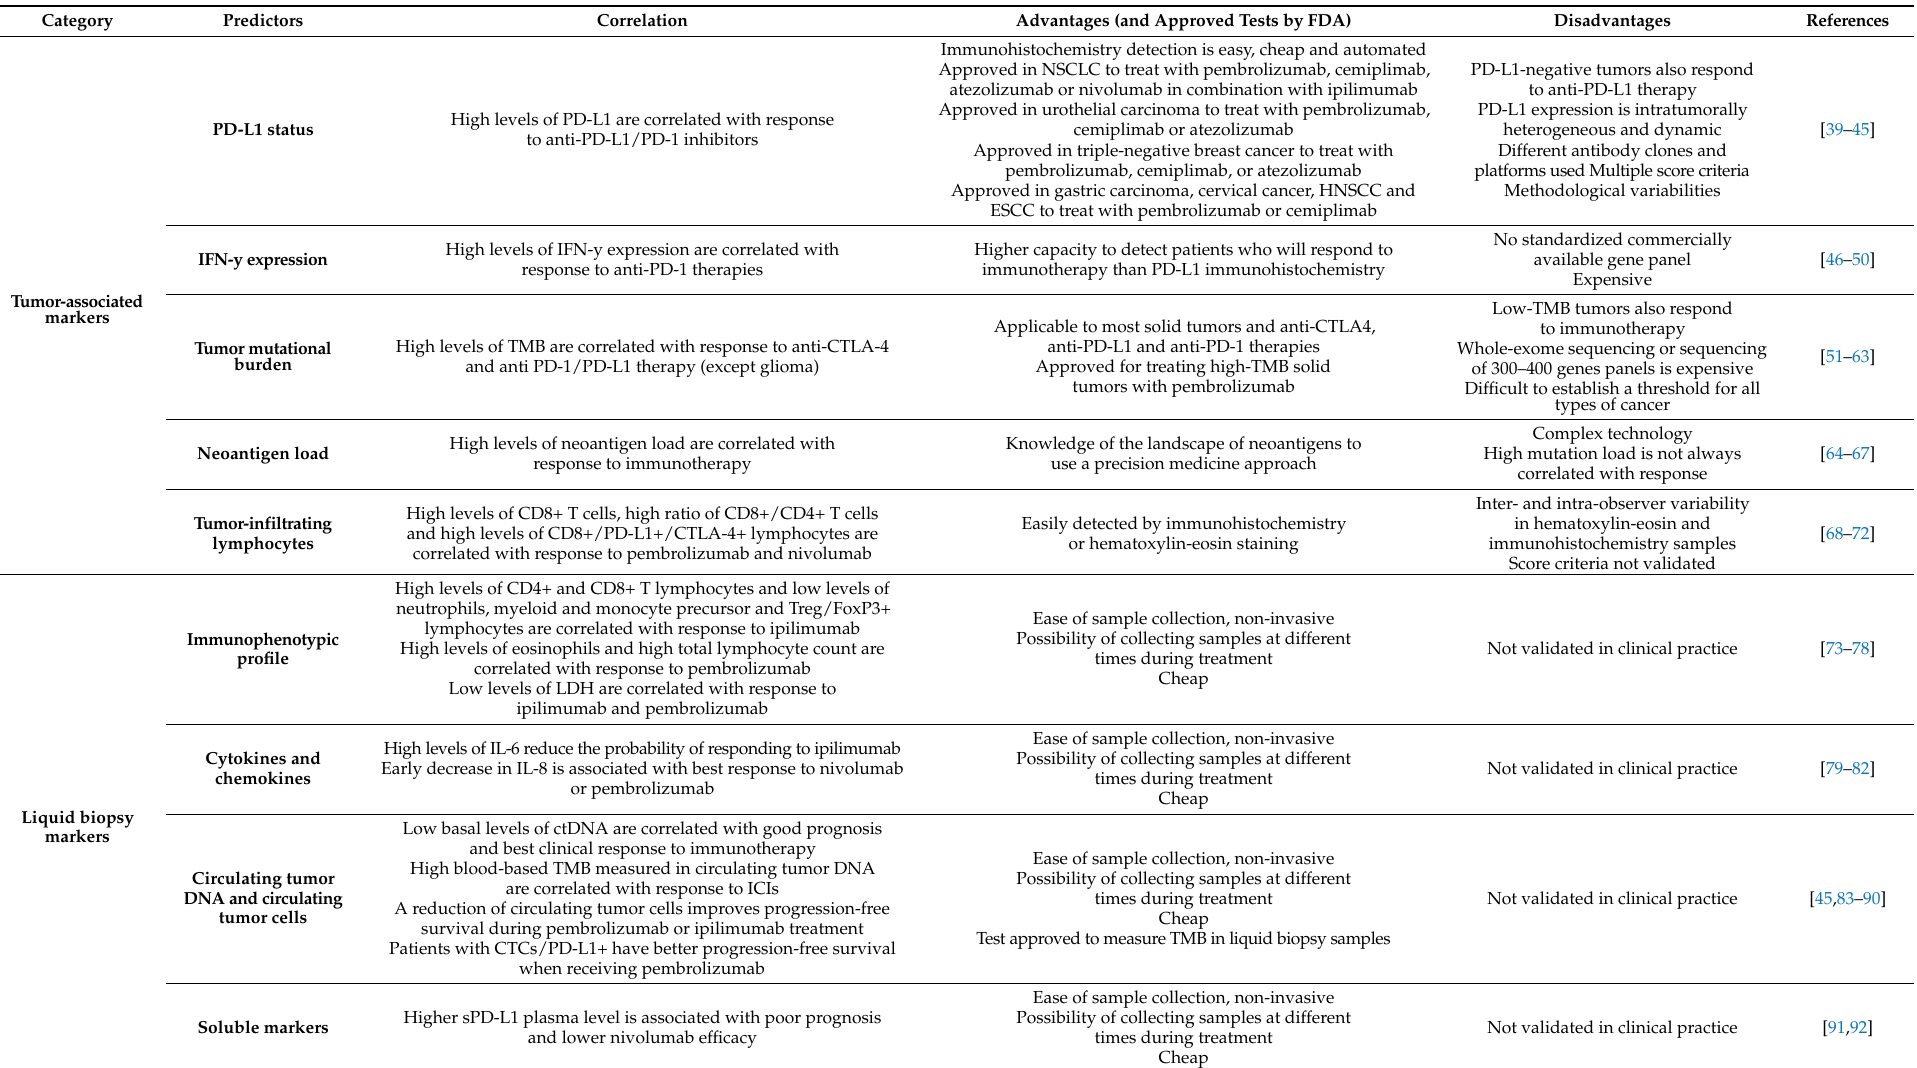
Table 1. Predictors of response to